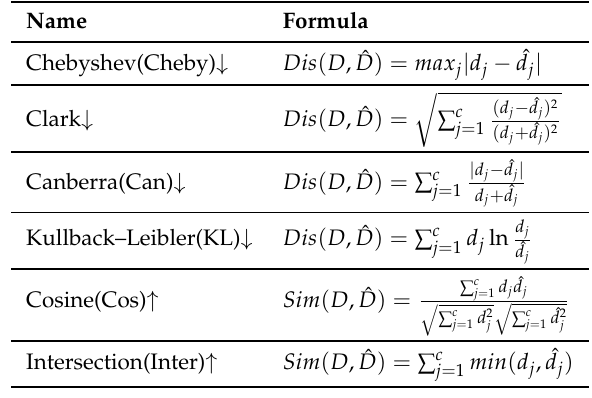
Table 2. Evaluation measure for LDL learners. ↓ means that the lowest value is the best and ↑ means the